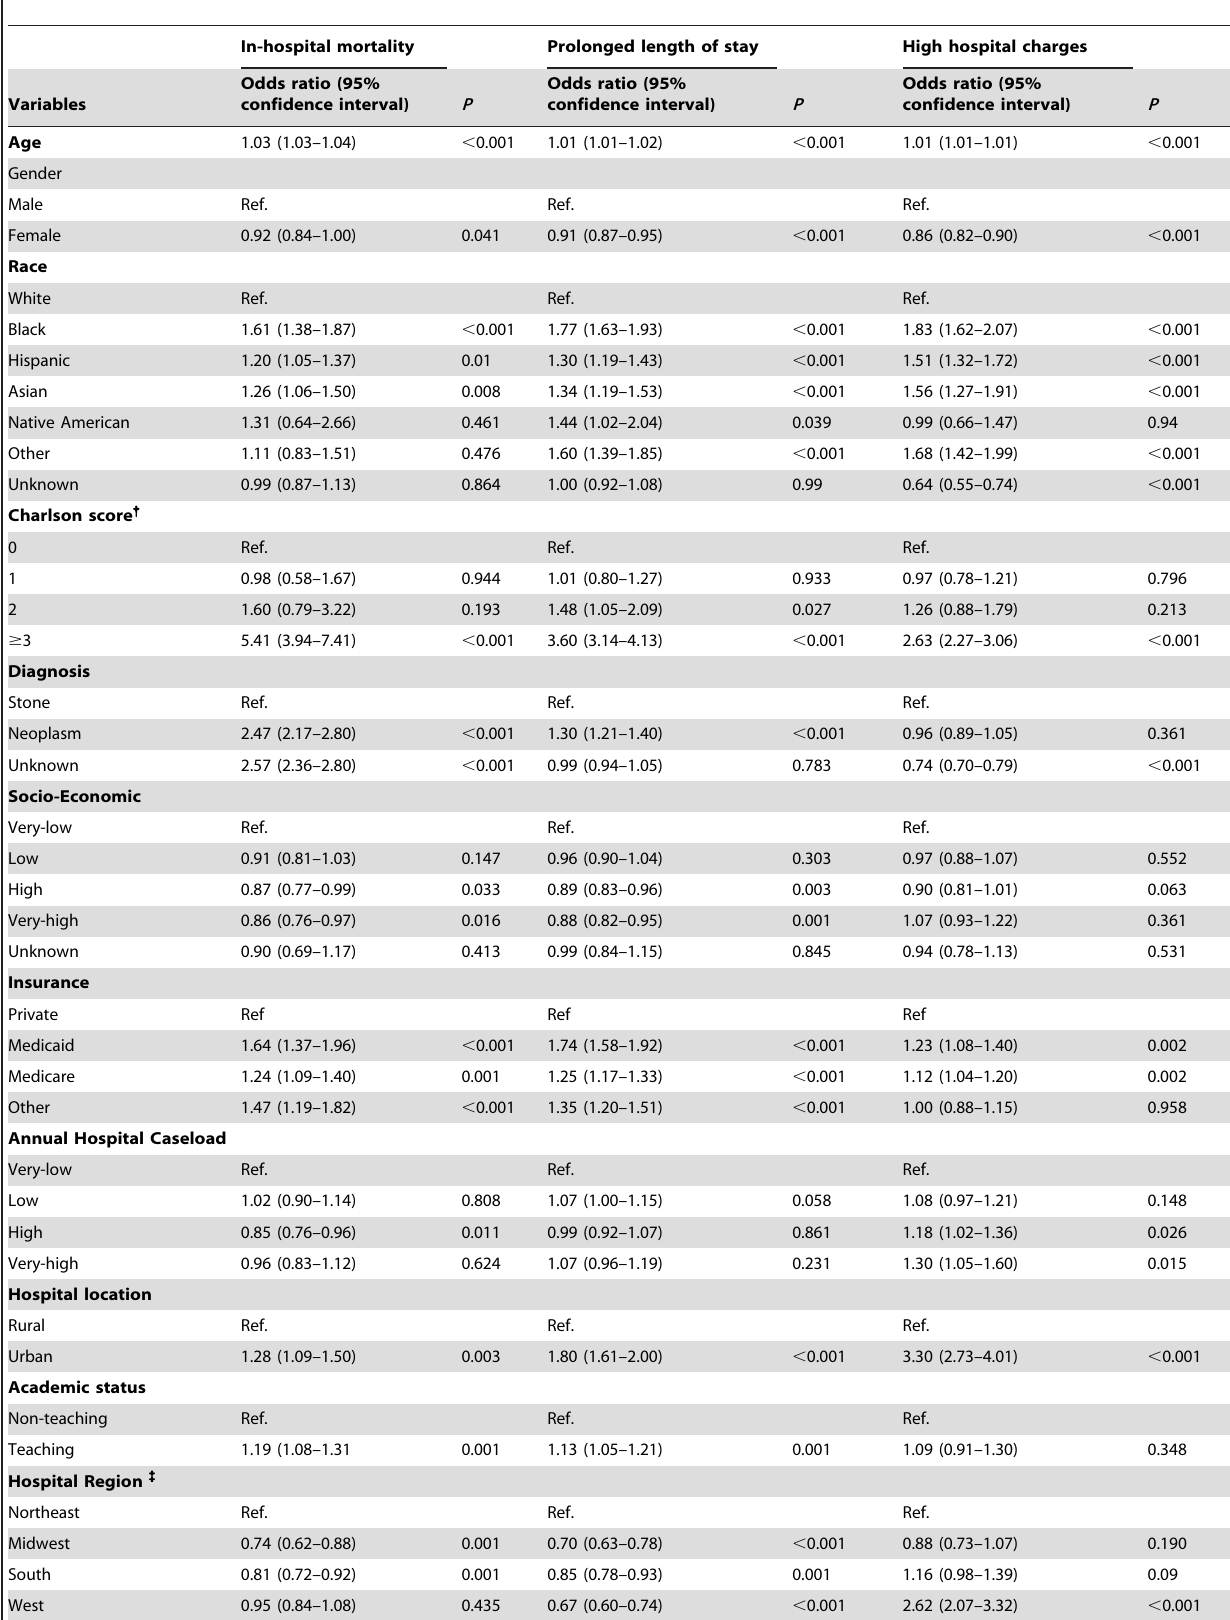
Table 3. Multivariable logistic regression analyses with general estimation equation adjustment assessing in-hospital mortality, prolonged length of stay and high hospital charges, Nationwide Inpatient Sample,